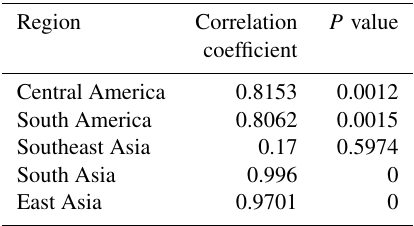
Table 2. Spearman’s rank correlation between mean daily rainfall and mean daily landslides by month (see Fig.